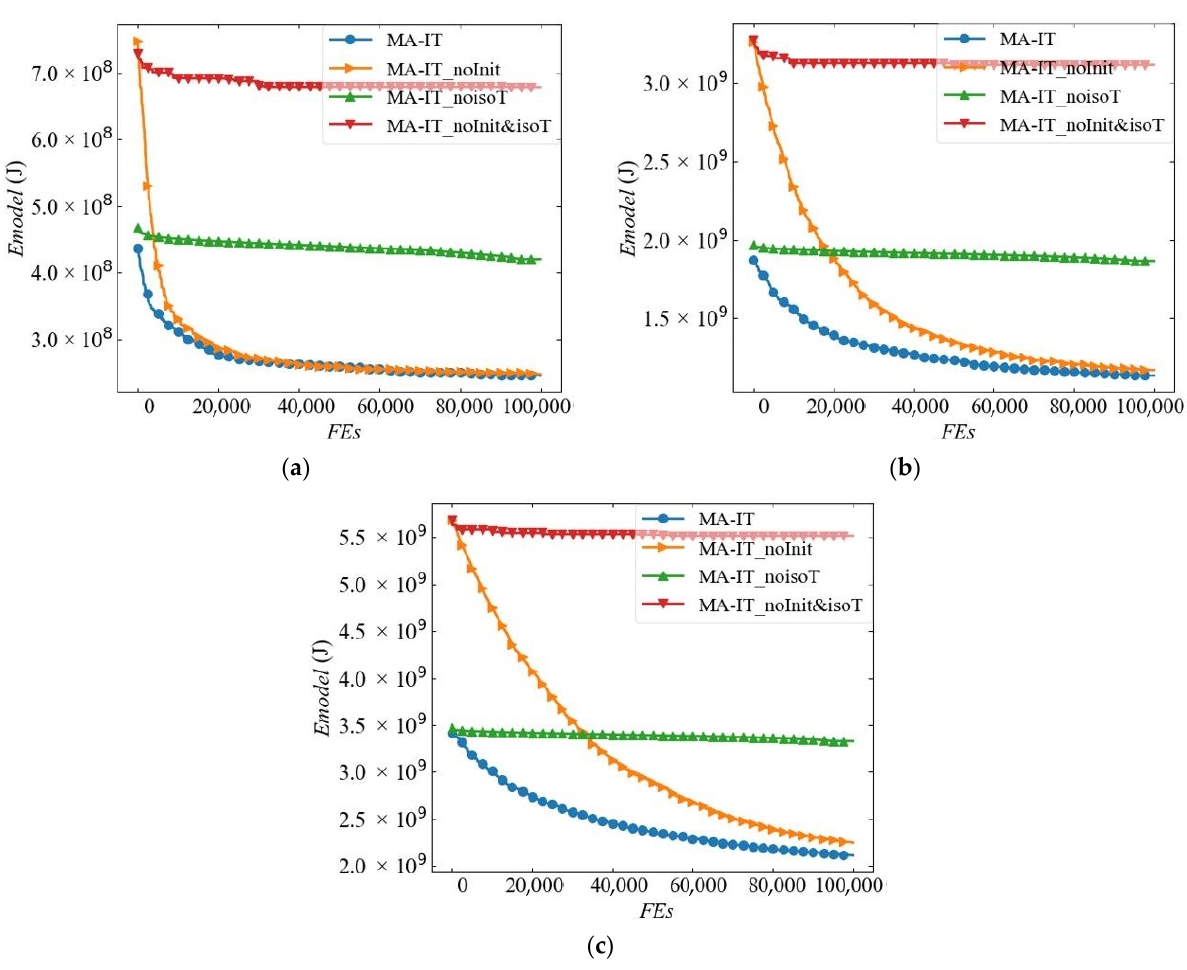
Figure 9. The results of different versions of MA-IT. ( a ) N = 100, ( b ) N = 400, and ( c ) N = 700.